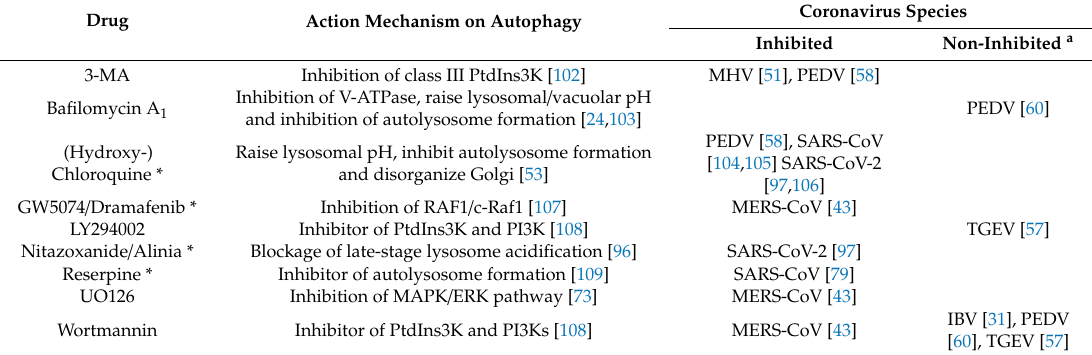
Table 5. E ff ect of autophagy modulators on the replication levels of coronavirus in cell cultures.